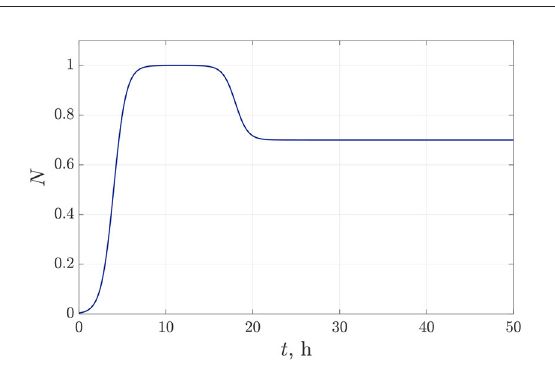
TABLE 1 Parameter values estimated for the bacterium P. putida .